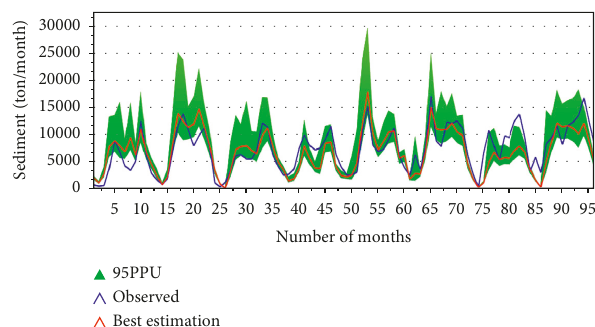
Figure 12: Scatter plot of simulated and observed sediment yield for calibration (1990–2005).